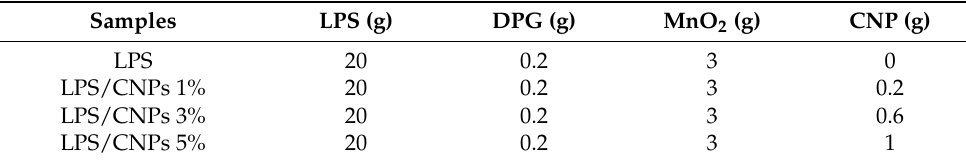
Table 2. The composition of LPS and LPS/CNPs